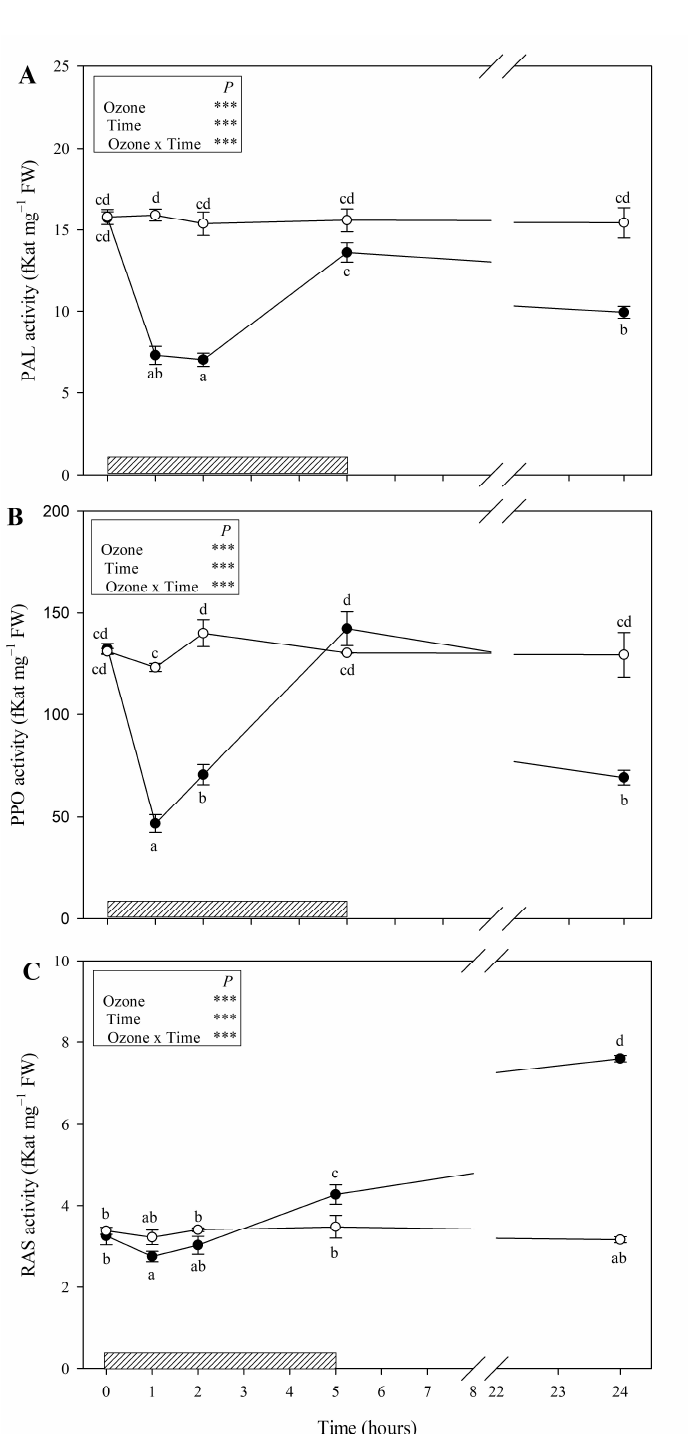
2 Figure 4. Time course of phenylalanine ammonia-lyase (PAL; ( A )), polyphenol oxidase (PPO; ( B )), and rosmarinic acid synthase (RAS; ( C )) activities in leaves of Salvia o ffi cinalis exposed to ozone (120 ppb, 5 h; closed circle) or maintained under filtered air (controls; open circle). Data are shown as mean ± standard deviation ( n = 3). Measurements were carried out at 0, 1, 2, 5, and 24 h from the beginning of exposure. Boxes show the results of a full factorial two-way ANOVA with ozone and time as variability factors (*** p ≤ 0.001). For each compound ( A – C ), di ff erent lowercase letters (a–d) indicate significant di ff erences among means, according to the Tukey’s HSD post-hoc test ( p ≤ 0.05). The dashed bar indicates the ozone treatment (i.e., 5 h). FW = fresh